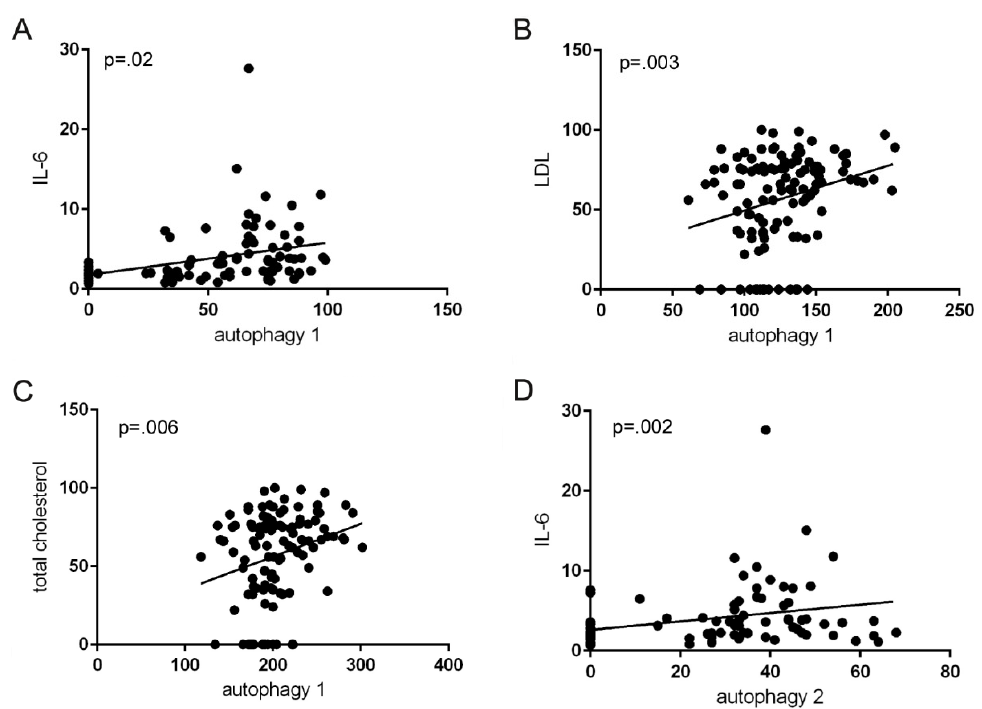
Figure 2. Simple scatter plots with regression line indicating significant positive direct correlations between IFIS for MAP-LC3 in the right colon (autophagy 1) and serum Il-6 ( A ), LDL ( B ), and total cholesterol ( C ), and between IFIS for MAP-LC3 in the left colon (autophagy 2) and serum IL-6 ( D ). In the left colon, the expression of MAPLC showed a positive correlation only with serum IL-6 ( p = 0.002) (Figure 2D) and a weak positive correlation with LDL ( p = 0.055).